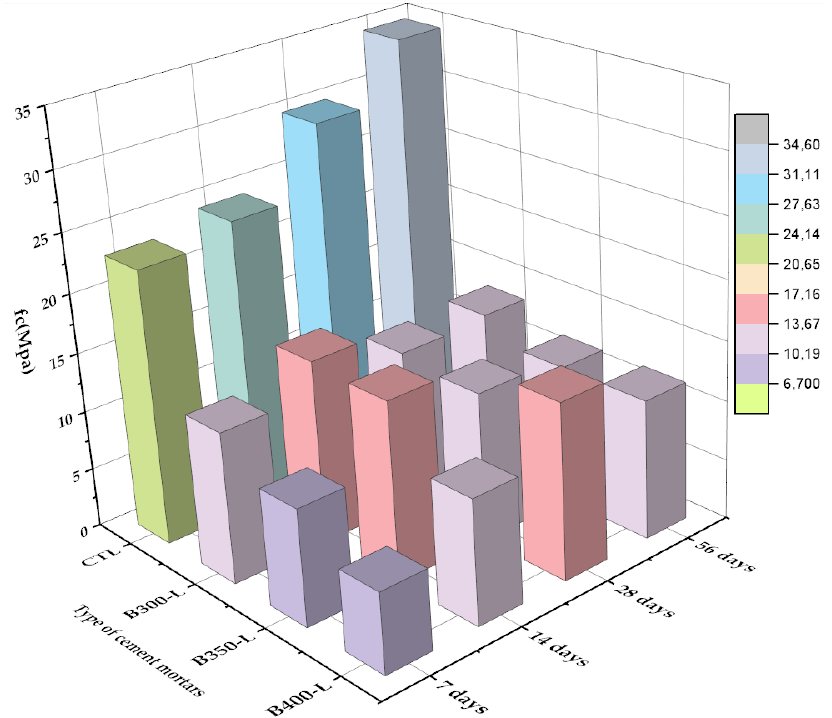
Figure 5. Compression test results for specimens with a partial replacement of cement with biochars produced at temperatures of 300, 350, and 400 °C after washing with water.